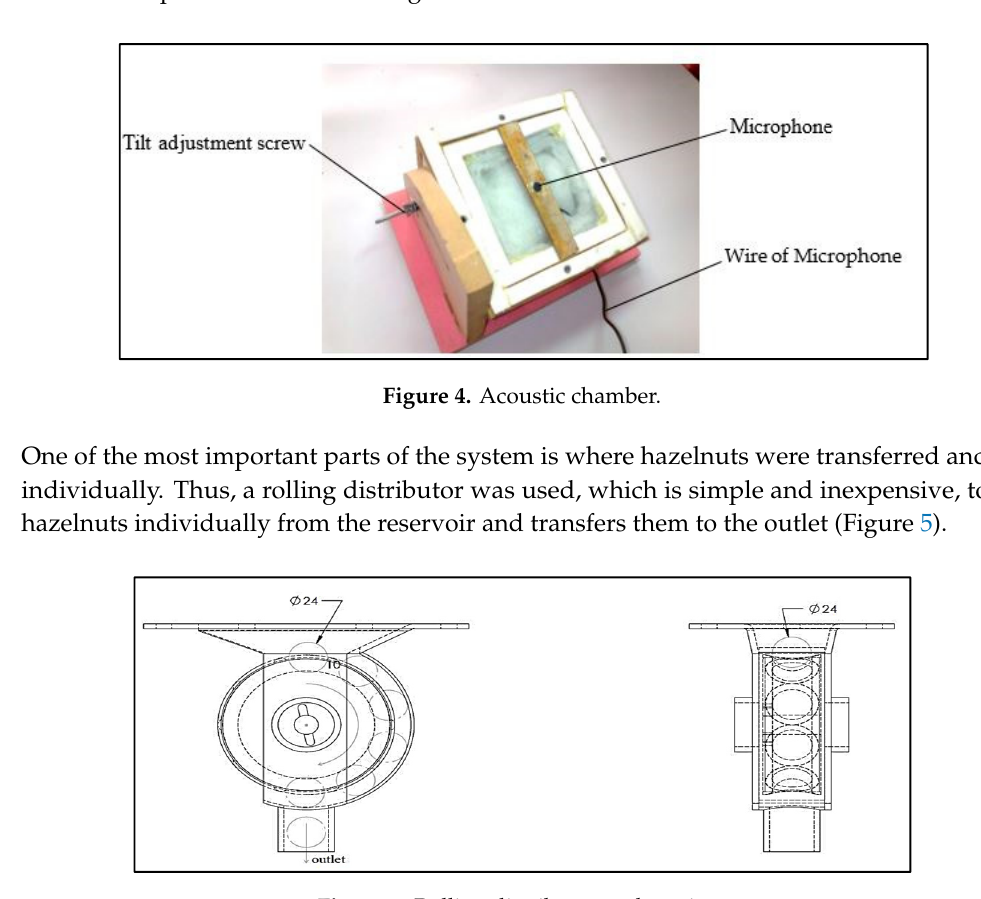
Figure 5. Rolling distributor and coating.